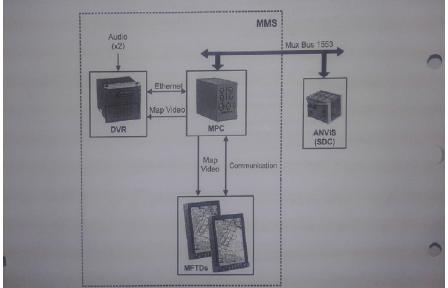
Figure 12 – MMS airborne system - general structure Рис . 12 – MMS воздушная система – базовая схема Слика 12 – ММЅ ваздушни систем – општа шема